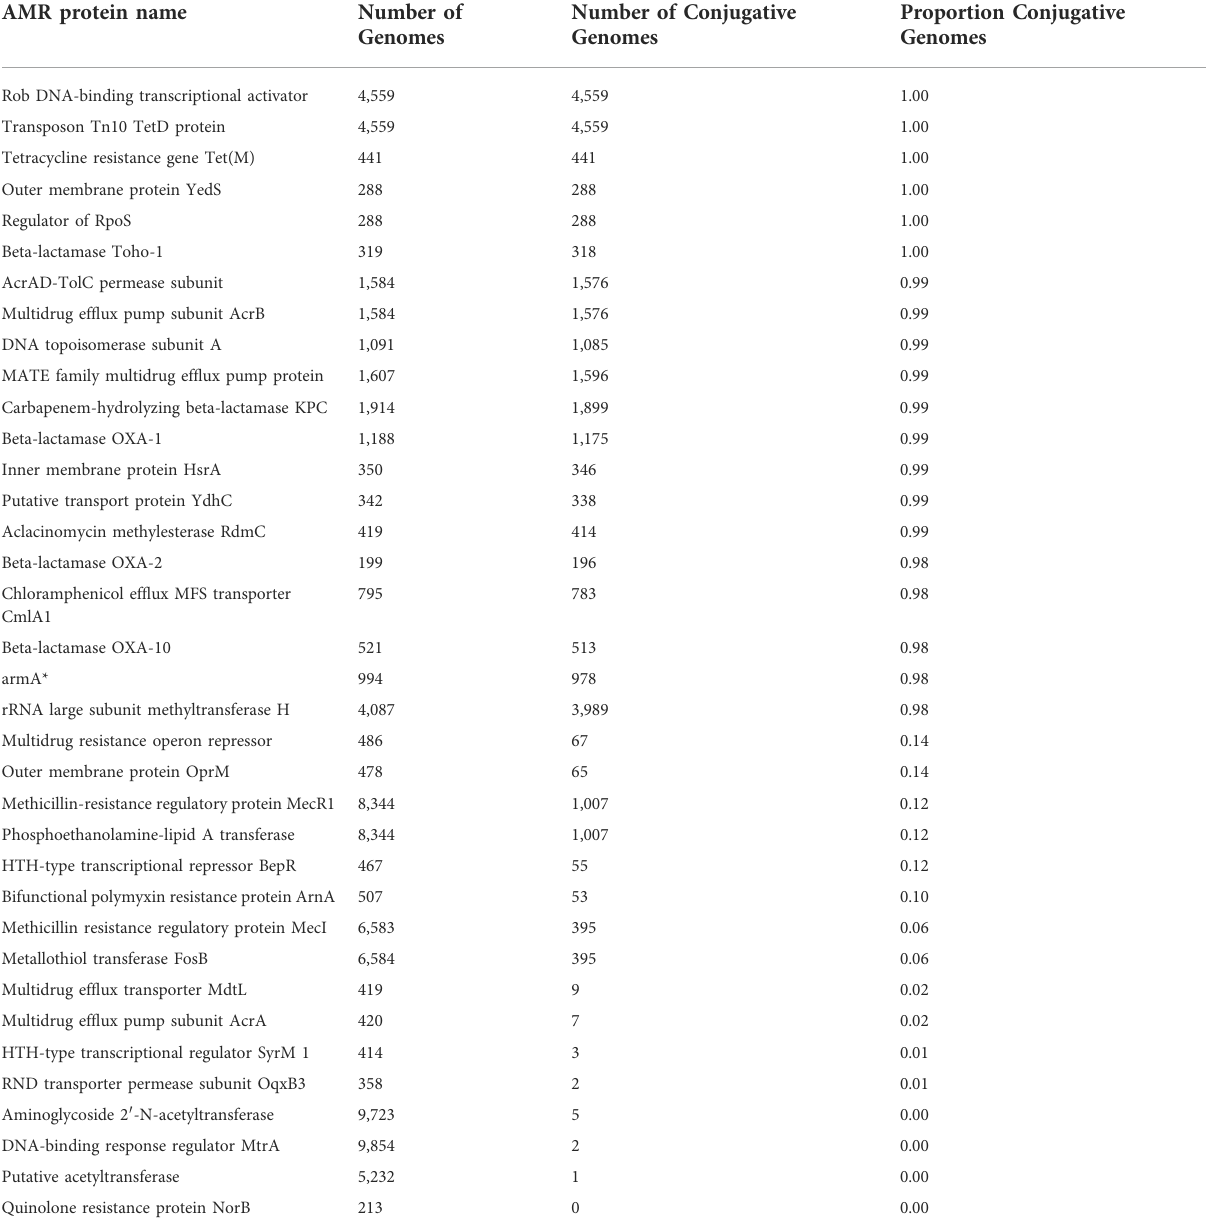
TABLE 4 Probability of observing AMR proteins in genomes that also contained conjugative